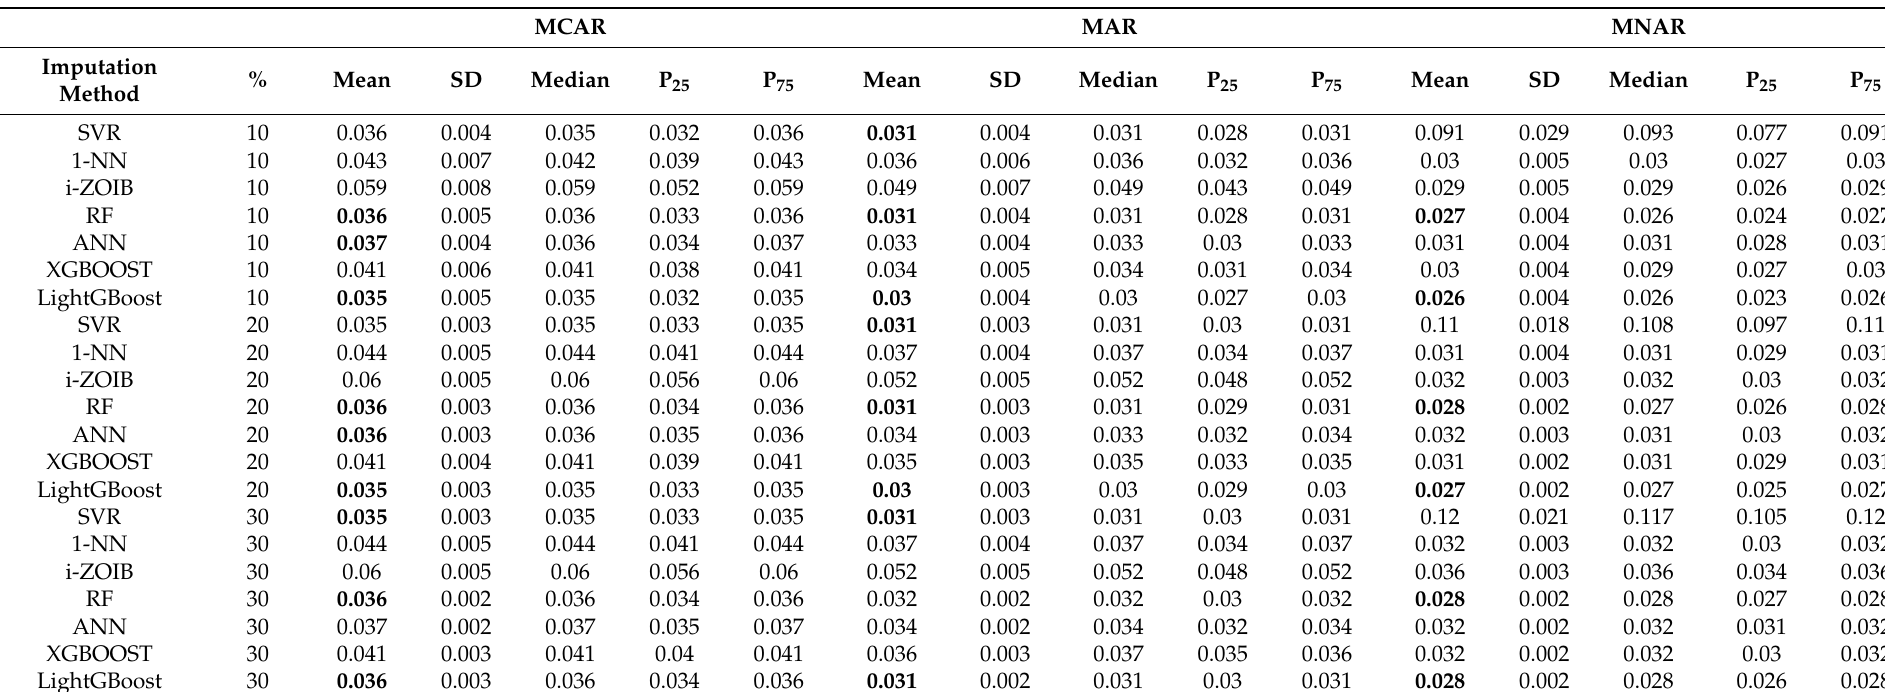
Table A5. Summary statistics of the MAE accuracy measure according to the missingness mechanisms, rates and imputation methods in the Scenario 3. MCAR MAR